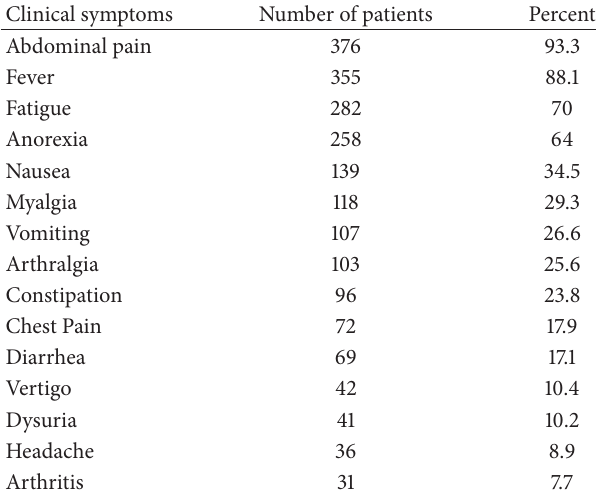
Table 1: Clinical findings in our